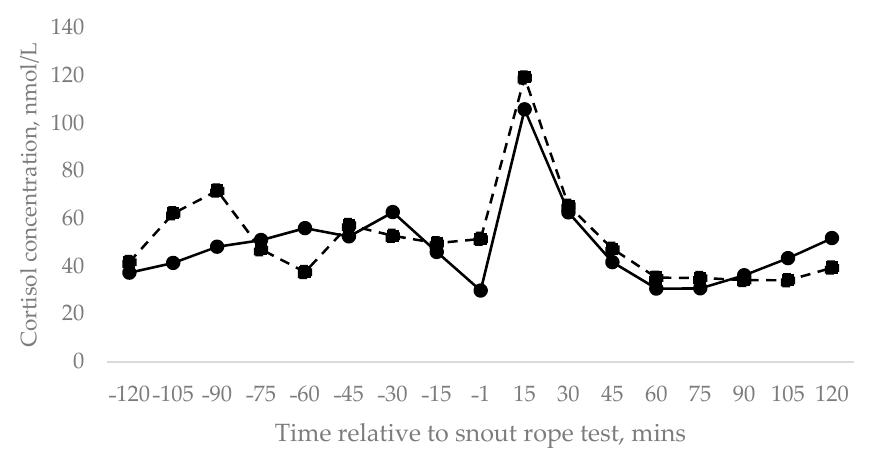
Figure 2. Sow cortisol concentration (nmol/L) in relation to the snout rope test which occurred at time zero. Data were sqrt transformed for analysis. Back transformed means are presented and therefore no SEM are present. Table 1. Effect of the synthetic olfactory agonist (SOA) and Control treatments on piglet measure- ments (mean ±